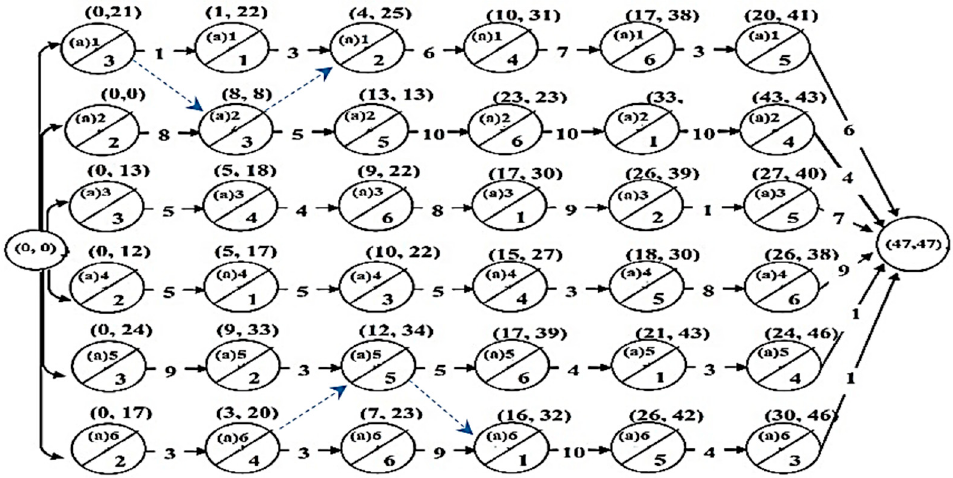
Figure 10. The DQN network for specific station from three different stations. = 6.25, α = 3.8, α = 2 } set is The fuzzy group FG i = { α a 1 → a 3 = J ( EVs ) a 4 → a 2 a 4 → a 6 1 ≈ J arranged in a descending order, this means the a 1 ∼ J ( EVs ) precedes a 4 ∼ J ( EVs ) 4 , and 1 4 ≈ J ≈ J ( EVs ) a 4 precedes a 6 ∼ J ( EVs ) 6 , a 2 ∼ J 2 . On the other hand, the remaining actions 6 2 have been tested in FG j which are arranged in ascending order, where α a 3 → a 6 = 0.3142, ≈ J ≈ J ( EVs ) α a 6 → a 3 = 0.44. Therefore, a 6 ∼ J ( EVs ) 6 precedes a 3 ∼ J 3 and so on as shown 6 3 in Table 5, which expounds 180 direct potential relations and 6! indirect